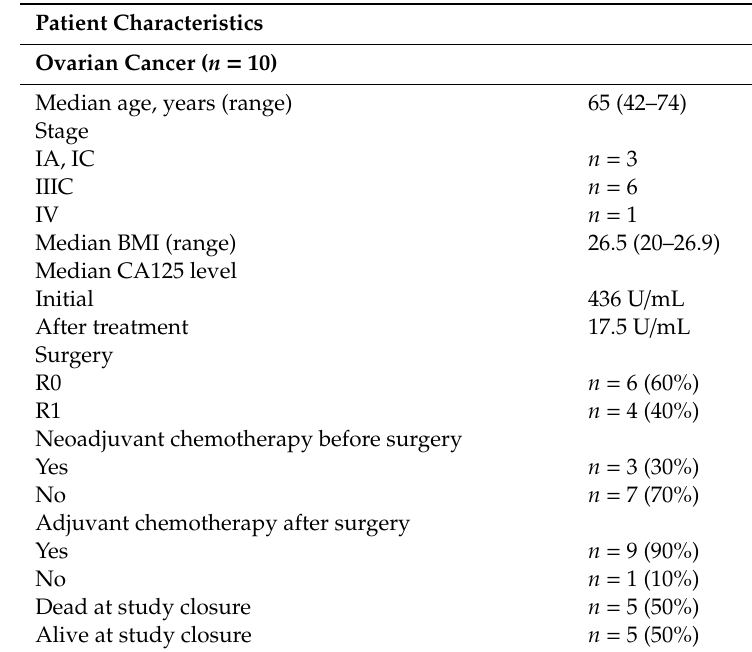
Table 2. Patient